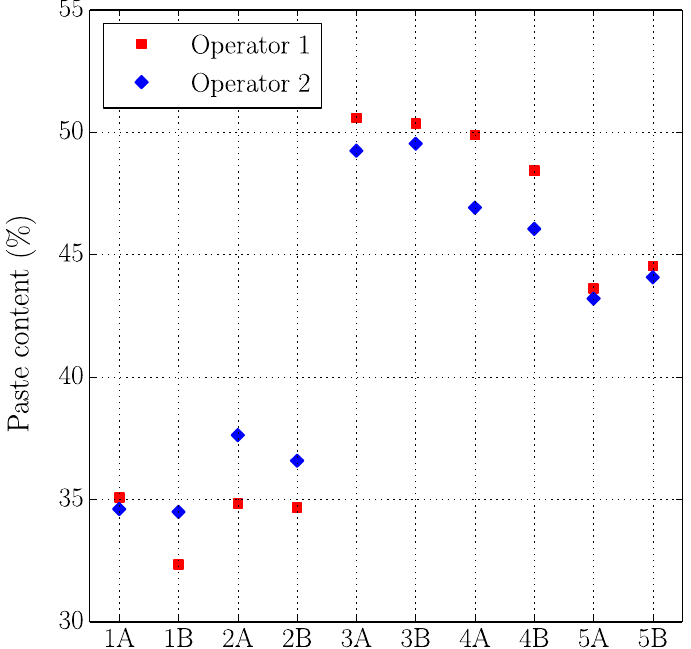
Figure 7. Results of the paste content (%) of the slabs studied by two distinct operators.